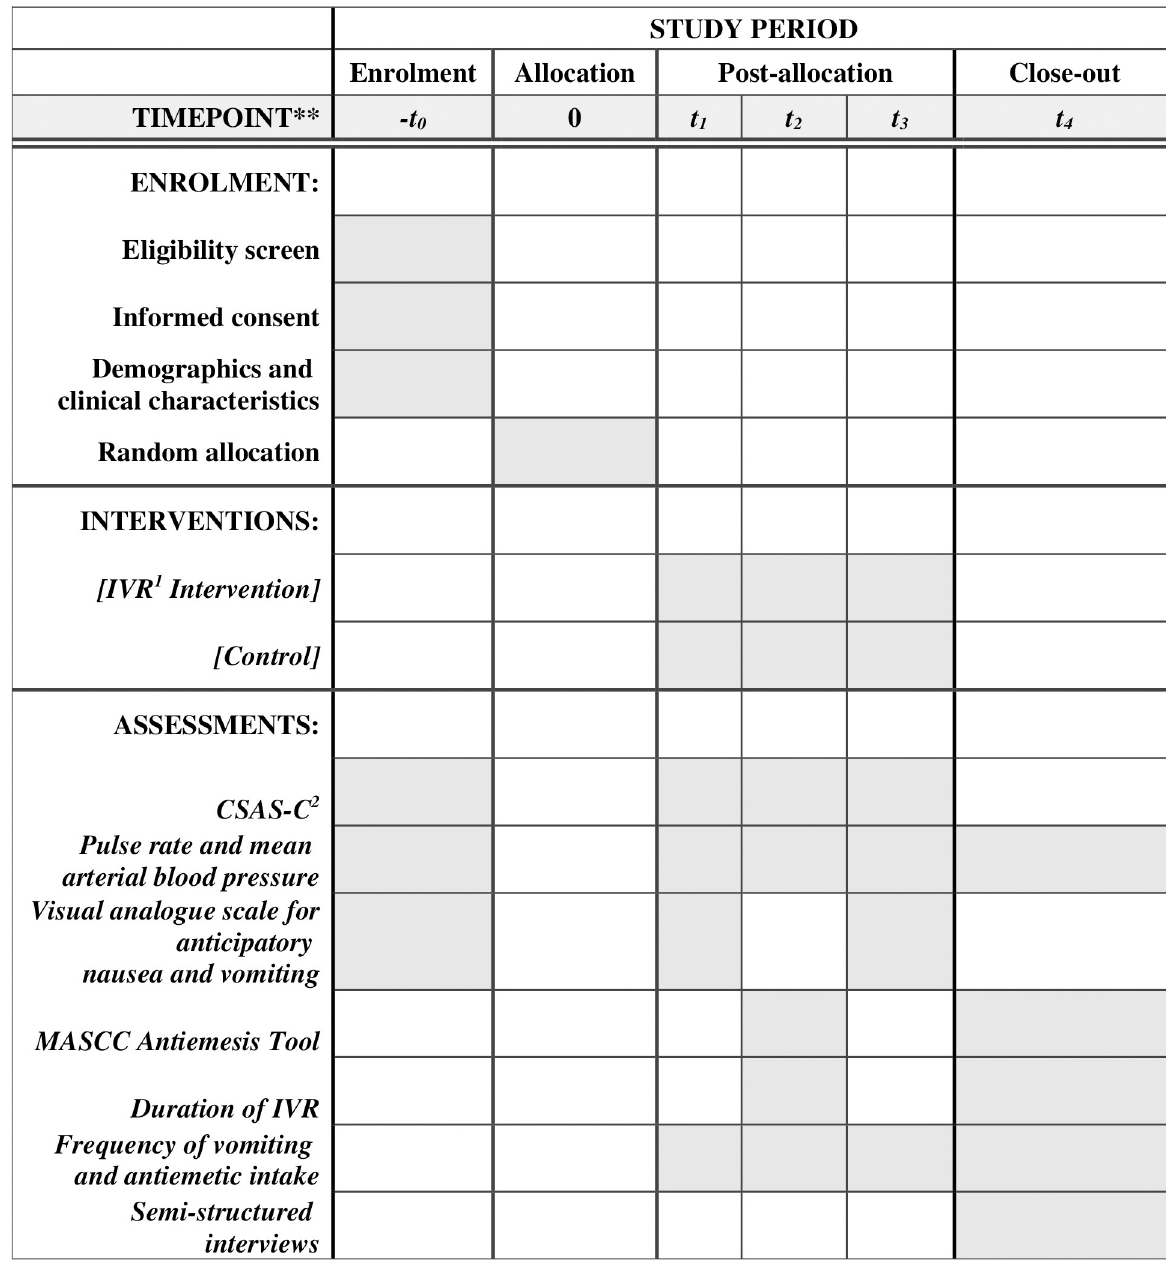
Fig 1. SPIRIT schedule of the trial. T0: Pre-test data 4 hours prior to chemotherapy; T1: Immediate before 1 st chemotherapy starts; T2: Immediate after 1 st chemotherapy; T3: Immediate before 2 nd chemotherapy starts; T4: Immediate after 2 nd chemotherapy. 1 IVR: Immersive virtual reality; 2 CSAS-C: The short form of the Chinese version of the State Anxiety Scale for